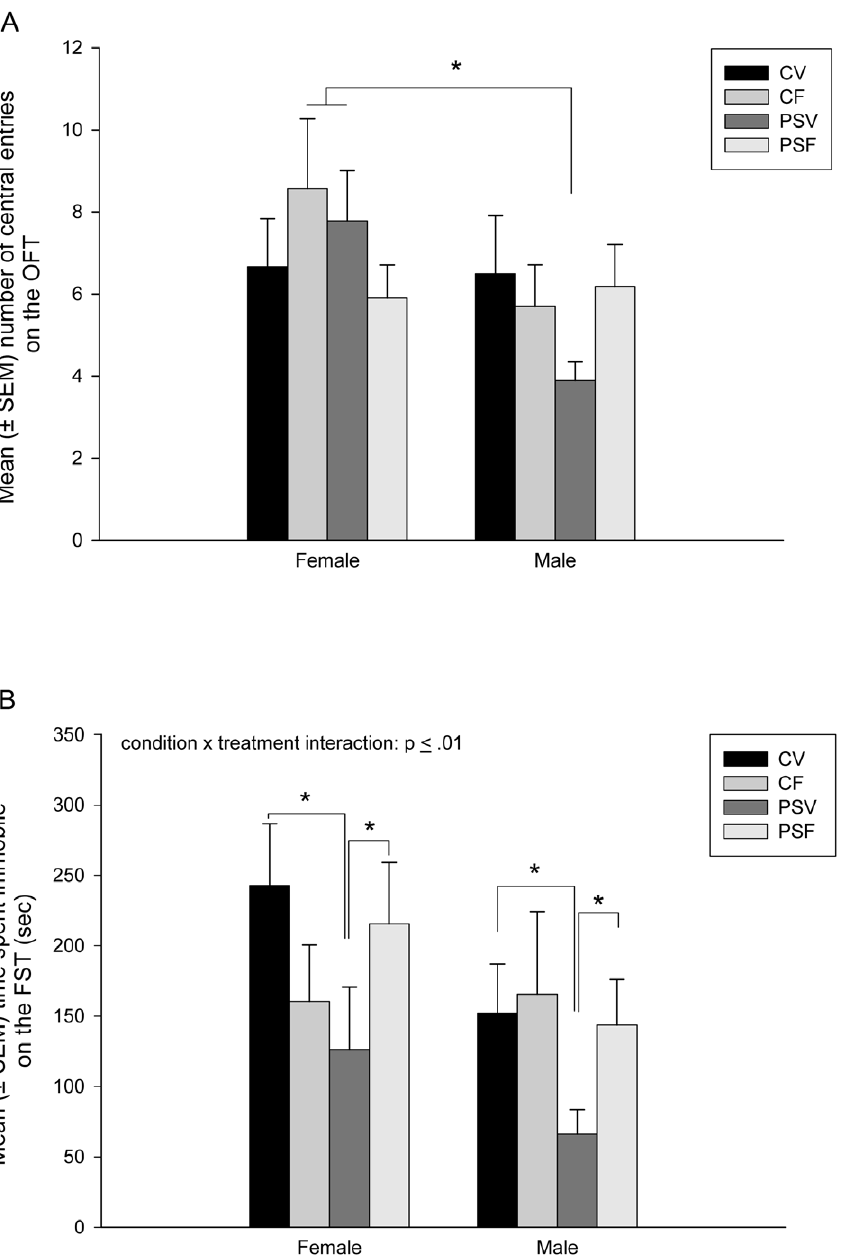
We also did not find a marked relationship between anxiety- like behaviors and measures of hippocampal neurogenesis in the adolescent rats. Previous work has demonstrated that hippo- campal neurogenesis is associated with anxiety-like behavior in adulthood; Revest et al (2009) demonstrated that transgenic mice with decreased levels of hippocampal neurogenesis had increased anxiety-like behavior [65]. However, more research is